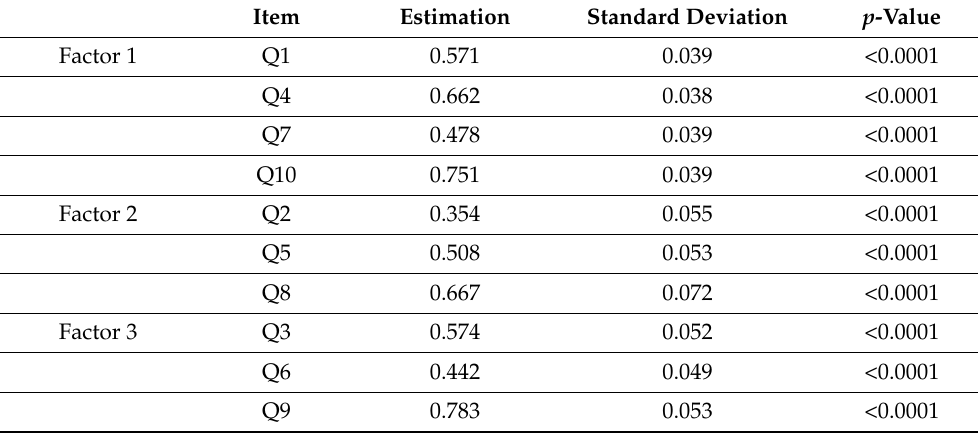
Table 6. Standardized estimators of latent variable saturation coefficients, pharmaceutical